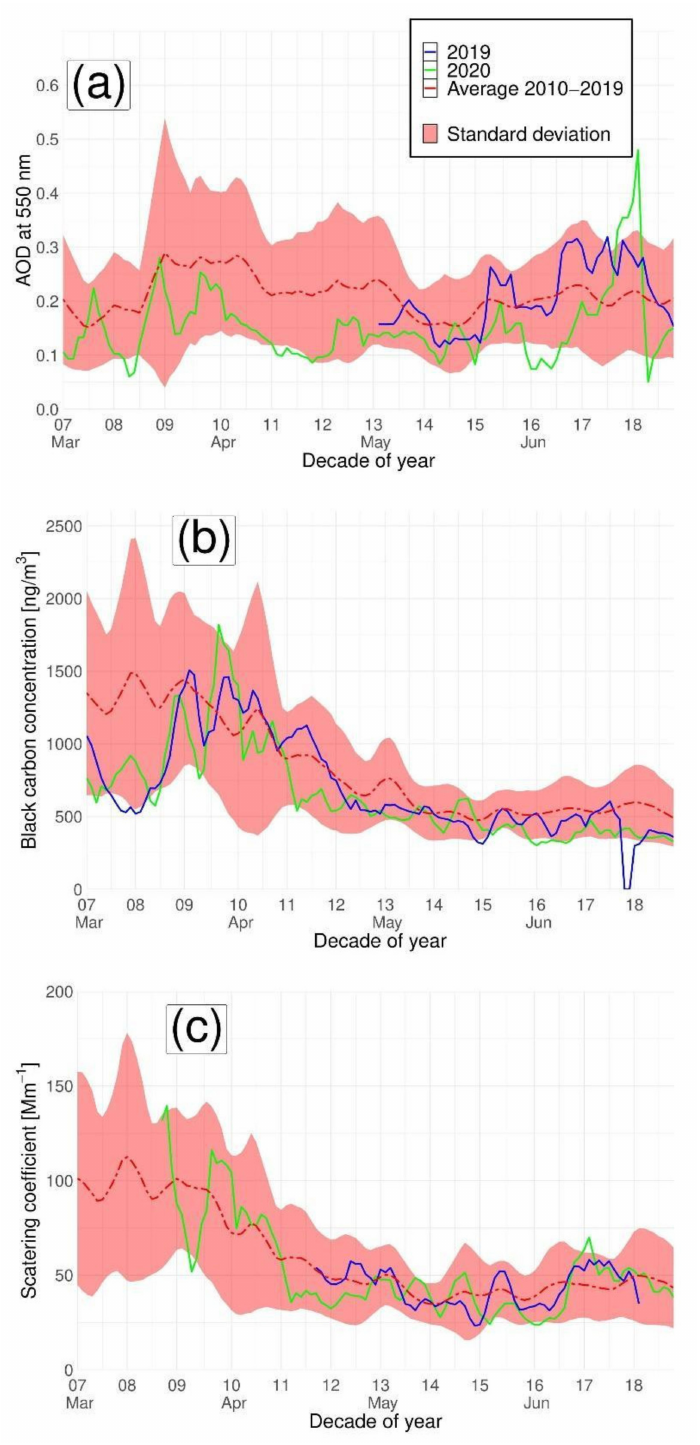
Figure 5. Temporal variability of 5-day running means ( a ) AOD at 500 nm obtained from the CIMEL sun photometer; ( b ) equivalent black carbon concentration (ng/m 3 ) from the AE-31 aethalometer; and ( c ) the aerosol scattering coefficient at 525 nm from the Aurora 4000 nephelometer, all at the Strzyzow station. Blue, green, and red lines correspond to 2019, 2020, and 2010–2019. The pink shadow indicates standard deviations for the 2010–2019